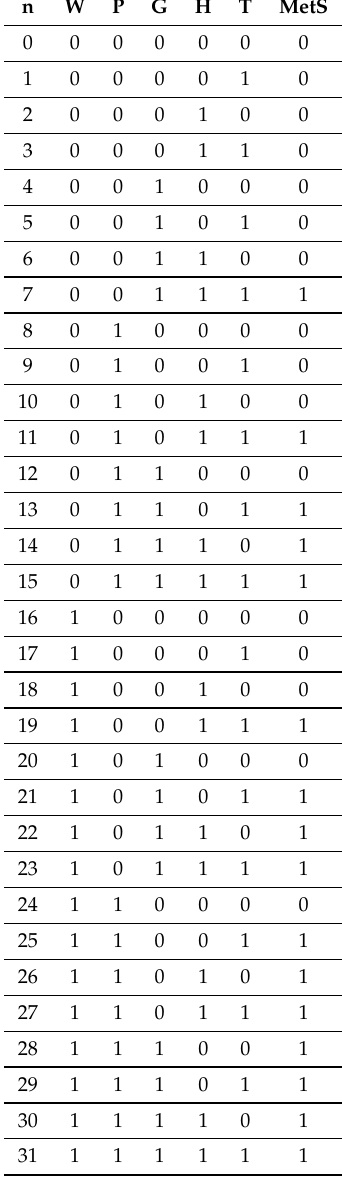
Table 3. Truth table of all the combinations of the risk factors of the MetS according to the HMS